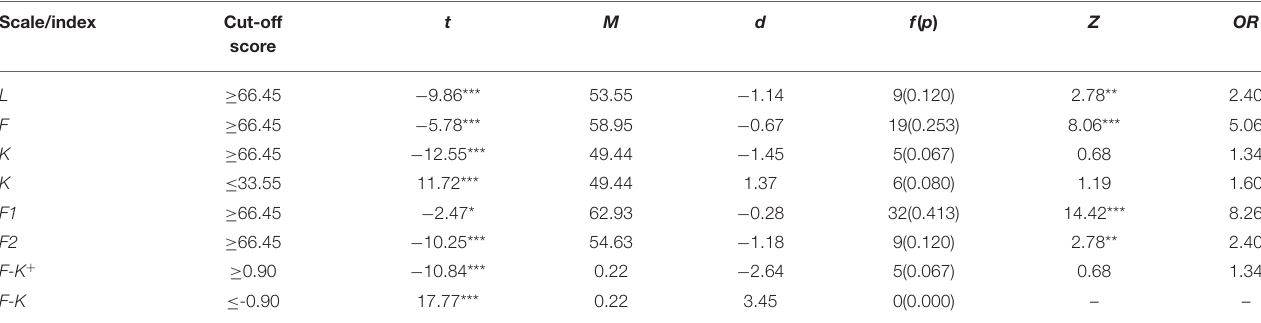
TABLE 1 | One-sample t -test for the comparison of the scales and indexes of malingering and defensiveness with a test value (cut-off score) and the contrast of the observed probability of malingering or defensiveness classification among CPOs with a constant (0.05).